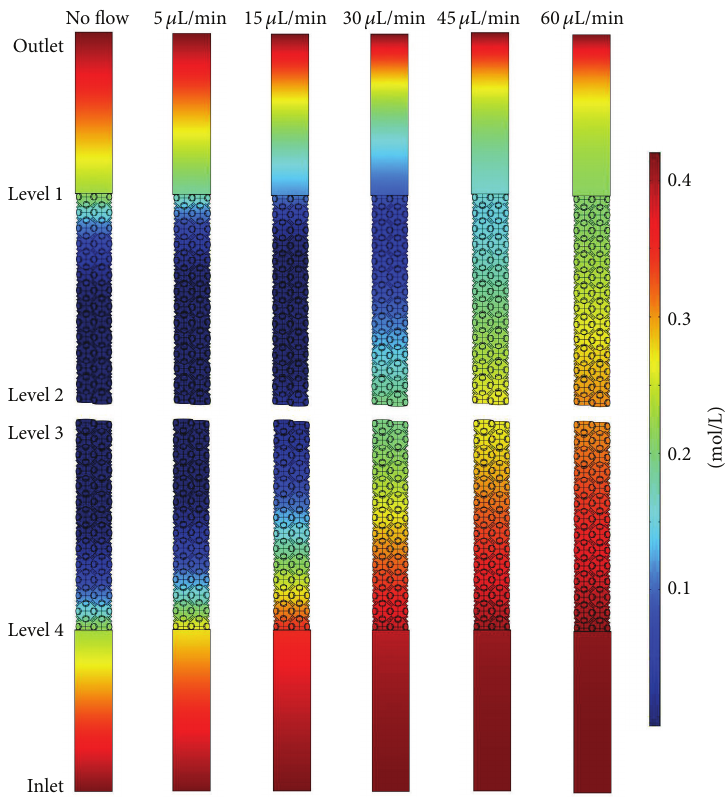
Figure 7: Local oxygen concentration in the simulation for different nutrient supply rates. The oxygen distribution shown is the balance between oxygen consumption in the cell-populated regions and oxygen supply by inflowing medium and by diffusion from the medium